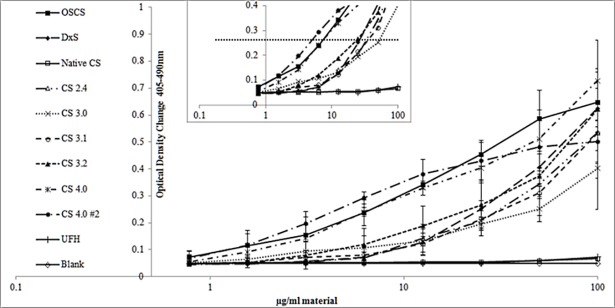
Kallikrein generation in normal pooled plasma by synthetic and purified OSCSs, native chondroitin sulfate, dextran sulfate and unfractionated heparin.Error bars = standard deviations (SD), n = 6, note lines for native CS, unfractionated heparin and plasma alone are overlapping. Inset chart shows line (….) indicating Δ0.2 OD above baseline used to select concentration of samples for the bradykinin assay.